Question: Which kind of chart has been used to present this data?
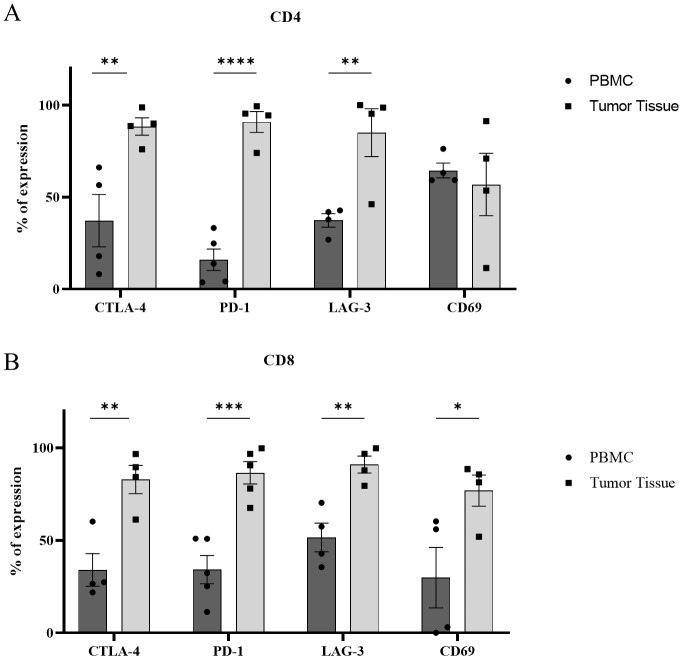
Answer: bar